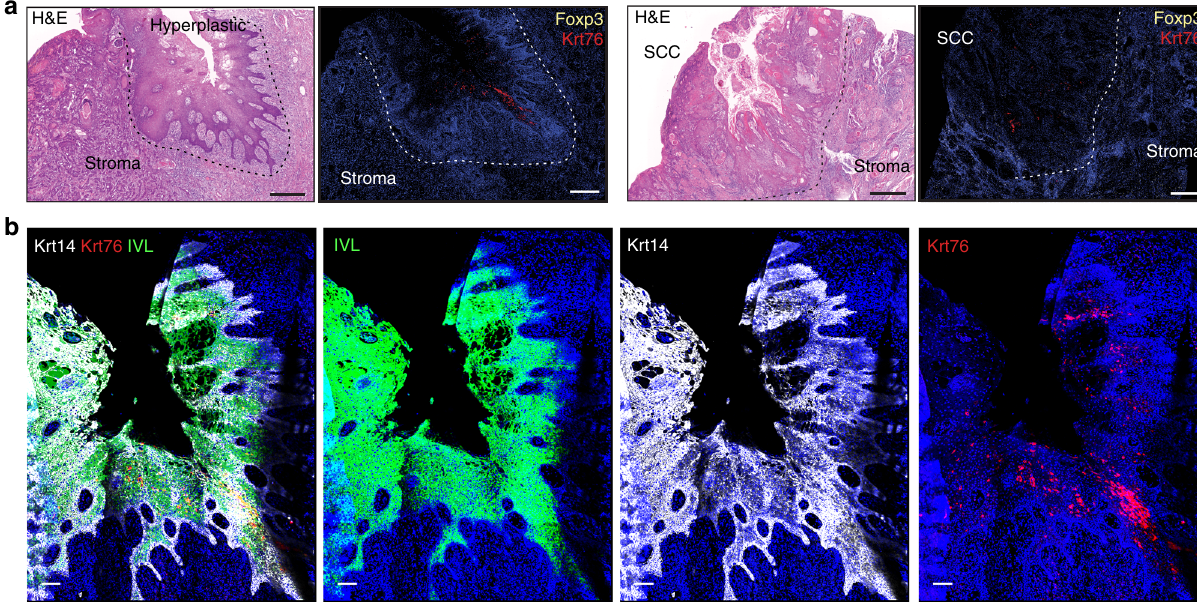
Fig. 7 Krt76 expression and Foxp3 + Treg in fi ltration in human OSCC. a Representative images of H&E staining and immunostaining for Krt76 and Foxp3 + Tregs in human OSCCs. b Representative images of immunostaining of Krt76, keratin 14 (Krt14) and involucrin (IVL) with nuclear DAPI counterstain in human OSCC. Scale bars: 100 µ